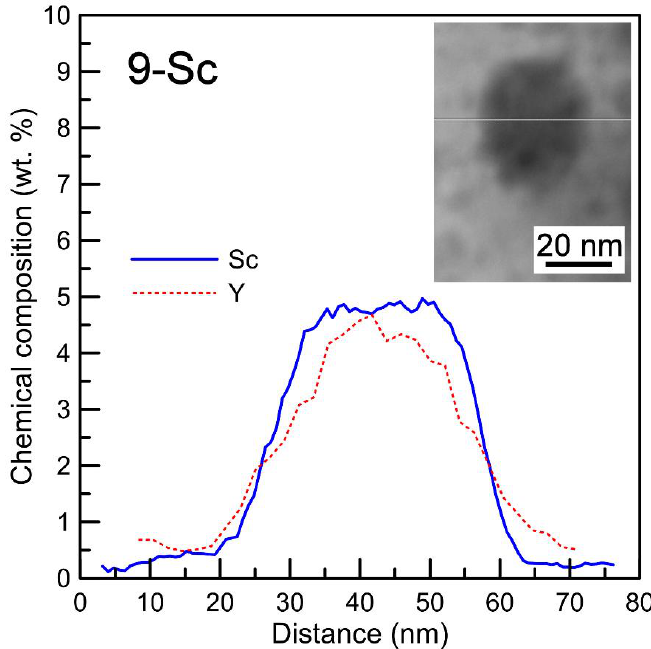
Figure 3. STEM-EDS analysis of an oxide particle from the dispersion in ODS 9-Sc steel. It was confirmed that the particle was rich in Y and Sc.